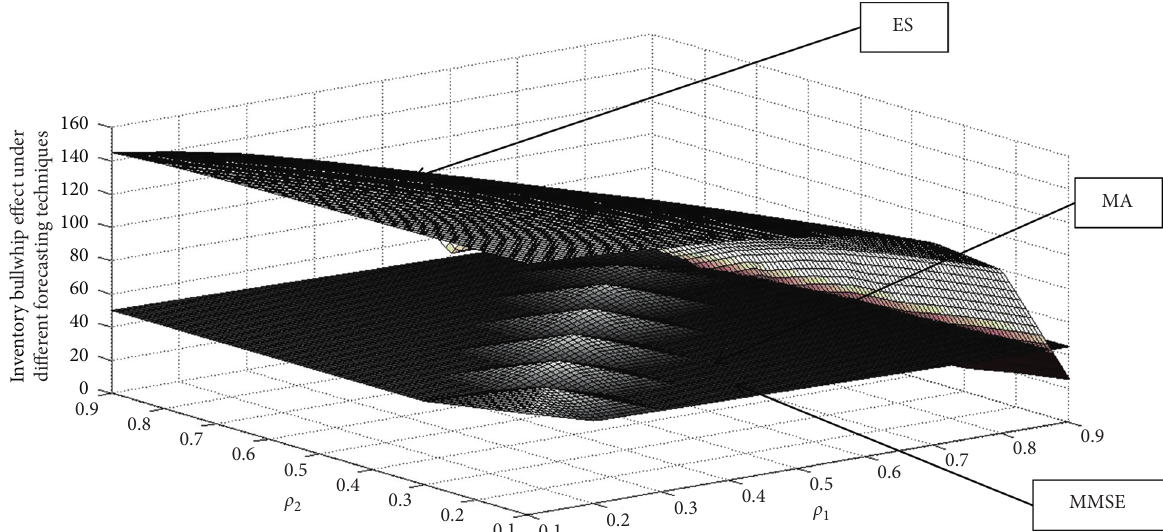
Figure 12: The impact of ρ